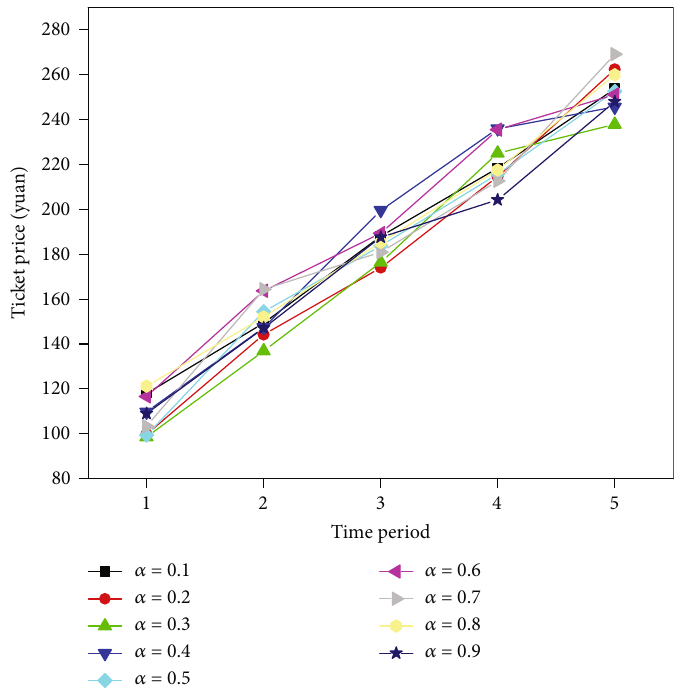
Figure 9: Ticket price of train A in OD 2.